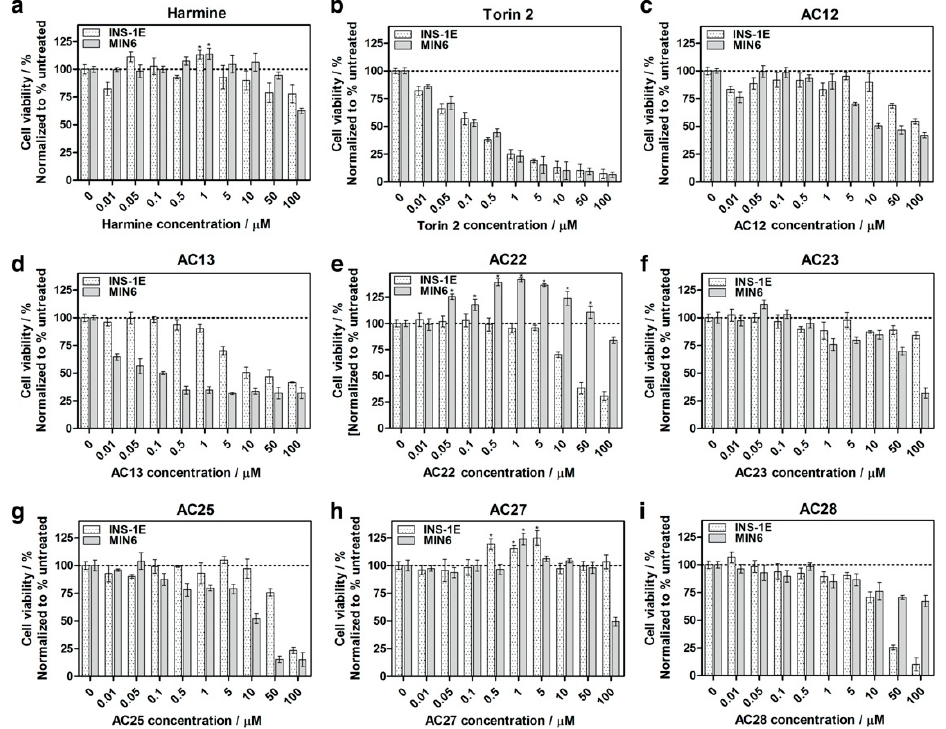
Figure 4. Relative viability of the MIN6 and INS-1E cell lines treated with Torin2, harmine and DYRK1A inhibitors in an MTT assay. The concentrations of the compounds ranged from 0 µ M to 100 µ M for ( a ) harmine, ( b ) Torin2, ( c ) AC12, ( d ) AC13, ( e ) AC22, ( f ) AC23, ( g ) AC25, ( h ) AC27 and ( i ) AC28. Data are expressed as mean ± SEM, * p < 0.05 as compared to the control.